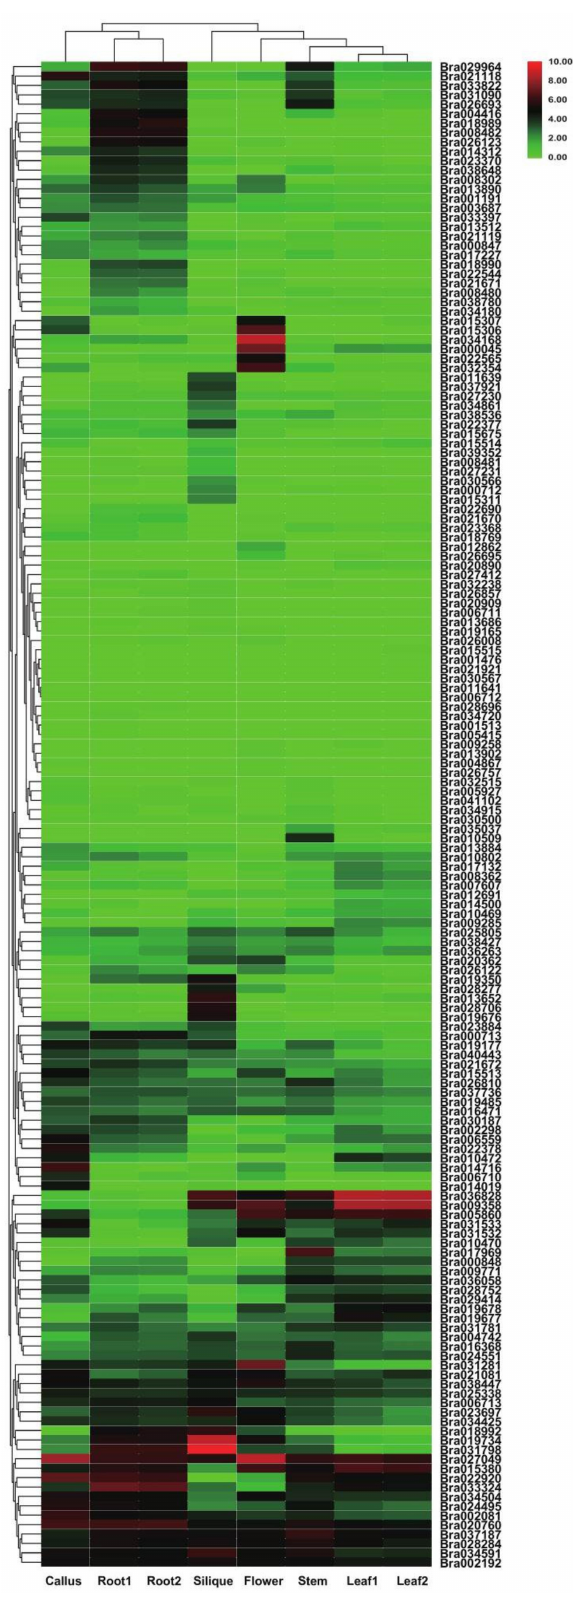
Figure 9. Tissue-specific expression of putative 2OGDs in B. rapa . Representative expression of putative 2OGDs of B. rapa in the callus, flower, root, leaf, and